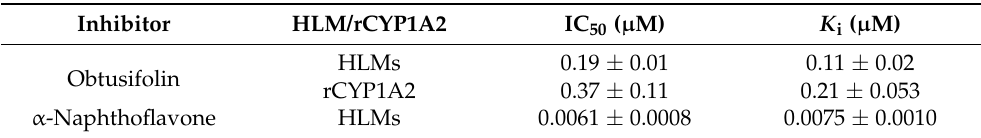
Figure 4. Representative Lineweaver – Burk ( A ), secondary Lineweaver – Burk ( B ), and Dixon plots ( C ) obtained from the inhibition kinetics of CYP1A2-mediated phenacetin O -deethylation in the presence of different concentrations of obtusifolin in human liver microsomes (HLMs). An increasing concentration of phenacetin (20, 50, and 100 µM) was incubated with HLMs (0.25 mg/mL) and an NADPH generating system at 37 °C for 15 min in the presence or absence of obtusifolin. The data are depicted as the average obtained from triplicate experiments ( n = 3). Table 3. Enzyme inhibition constants ( K i values) for the inhibition of CYP1A2-mediated phenacetin O -deethylation in human liver microsomes (HLMs) or recombinant CYP1A2 isoform by obtusifolin and ɑ -naphthoflavone.